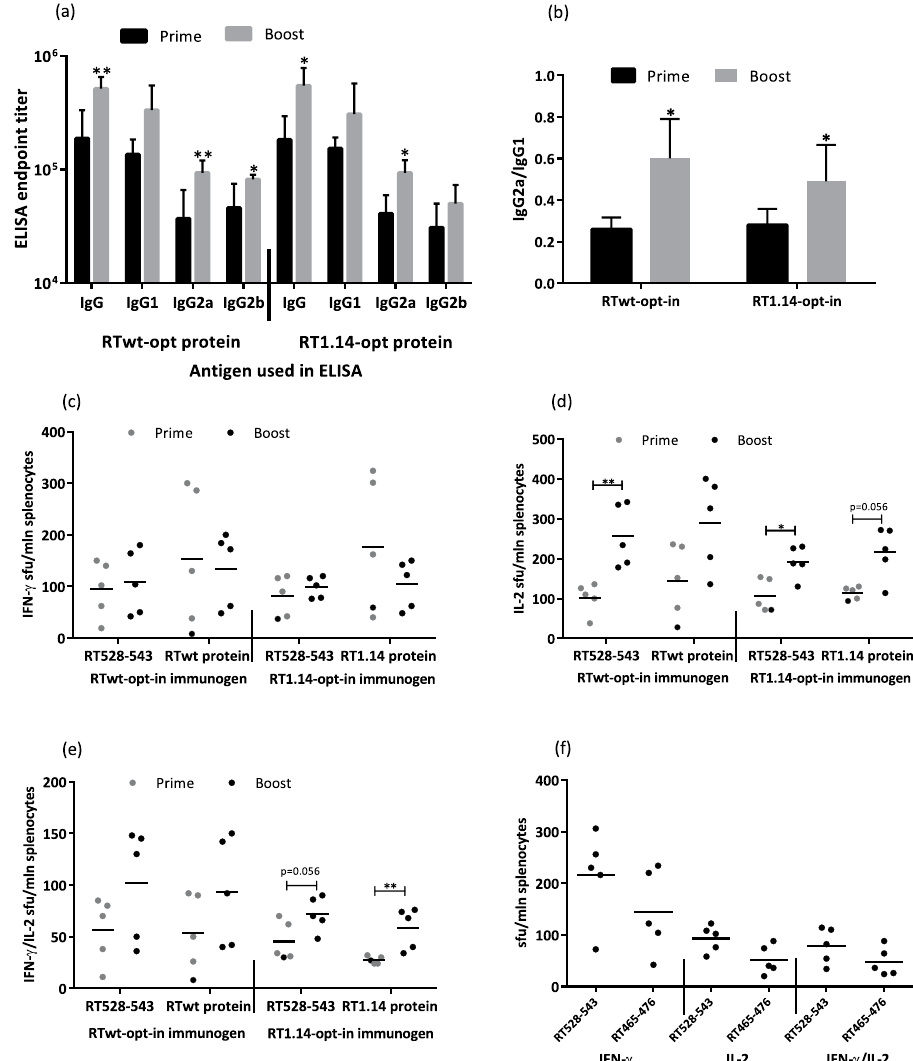
Figure 3. RT-specific antibody and cellular responses after repeated immunization with expression-optimized RT genes. BALB/c mice (n = 5 or 6) were immunized with two intradermal injections (29G needle) containing 40 µ g of RTwt-opt-in or RT1.14-opt-in encoding plasmids per mouse, with subsequent electroporation by Dermavax (standard protocol). Immunizations were repeated 4 weeks later with 20 µ g of RTwt-opt-in or RT1.14-opt-in encoding plasmids (( a – e ) prime-boost regimen, “Boost” on the graph) or 5 days later with 20 µ g of RTwt-opt-in encoding plasmid (( f ) double prime). Two independent immunizations were performed. At 21 days after the second immunization, mice were sacrificed and sera and splenocytes were isolated and subjected to immune tests. Endpoint average titers of anti-RT total IgG and IgG subtypes (the error bars represent the SD) were detected using ELISA against recombinant RTwt and RT1.14 proteins with cut-offs set against serum reactivity of control mice immunized with vector pVax1 ( a ), and the IgG2a/IgG1 ratio was calculated for antibody reactivity against RT variants matching RT used as the DNA immunogen ( b ). Splenocytes were stimulated in vitro with RT-derived peptides representing epitopes of RT aa 528–543 ( c – f ) and aa 465–476 (( f ) Table 2) or recombinant RTwt and RT1.14 proteins (( c – e ) matching the immunogen) in IFN- γ /IL-2 Fluorospot tests ( c – f ). The average number of cells was registered as signal-forming units (sfu) per million splenocytes secreting IFN- γ ( c , f ) IL-2 ( d , f ) and IFN- γ /IL-2 ( e , f ) and the error bars represent the SD. IFN- γ /IL-2 production by splenocytes of mice receiving prime-boost immunization compared to single immunization (( c – e ) single immunization from Fig. 2) or double prime immunization with the RTwt-opt-in gene ( f ). All assays were performed in duplicate. * p < 0.05; ** p < 0.01; p-values on the graph in the interval 0.05 to 0.1 indicate tendencies. Statistical comparisons were performed using Kruskal–Wallis and Mann–Whitney